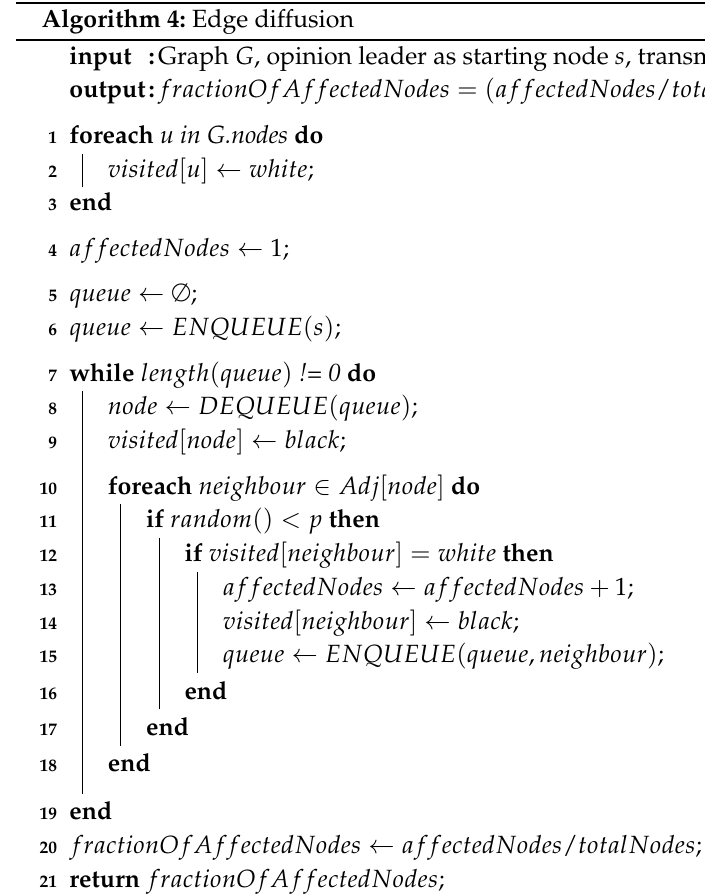
Algorithm 4: Edge